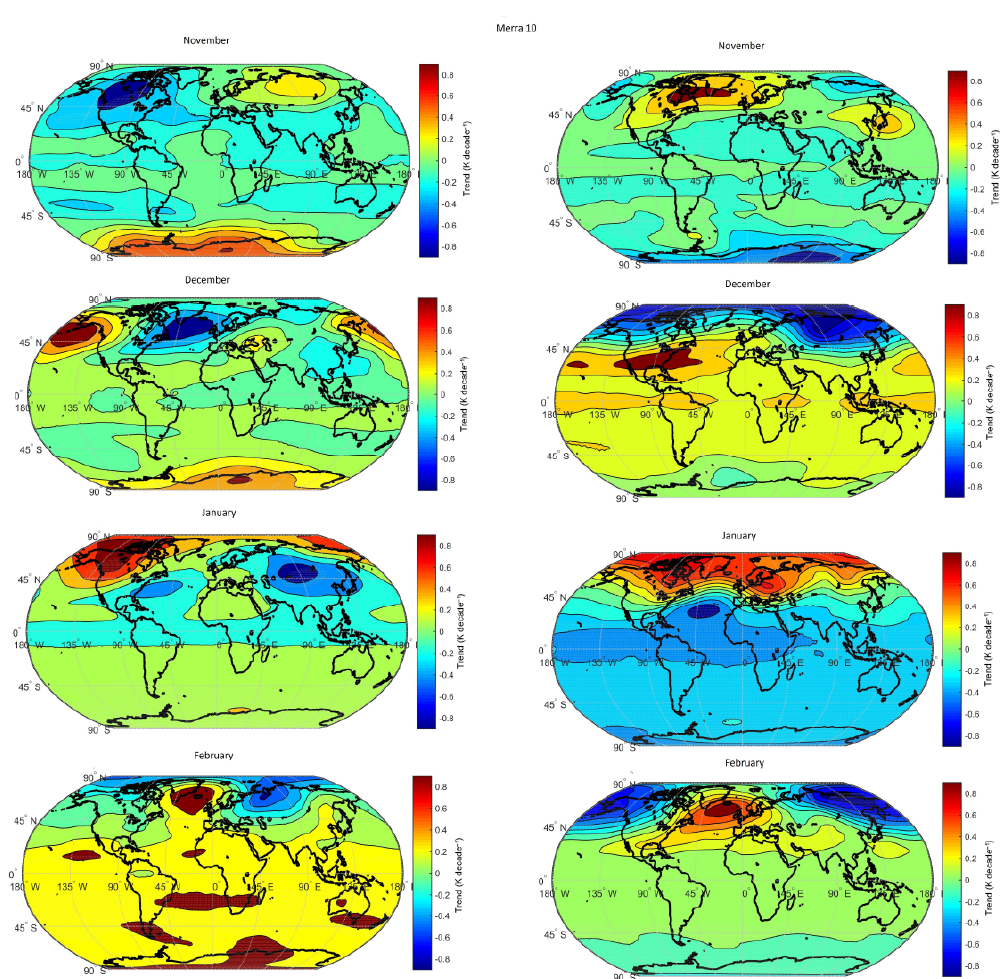
Figure 12. Temperature trends (Kdecade − 1 ) for different months (November, December, January and February) at 10hPa from the MERRA reanalysis. Left panels show 1979–1997 and right panels show 1998–2015. Statistical significance (95%) is highlighted by white